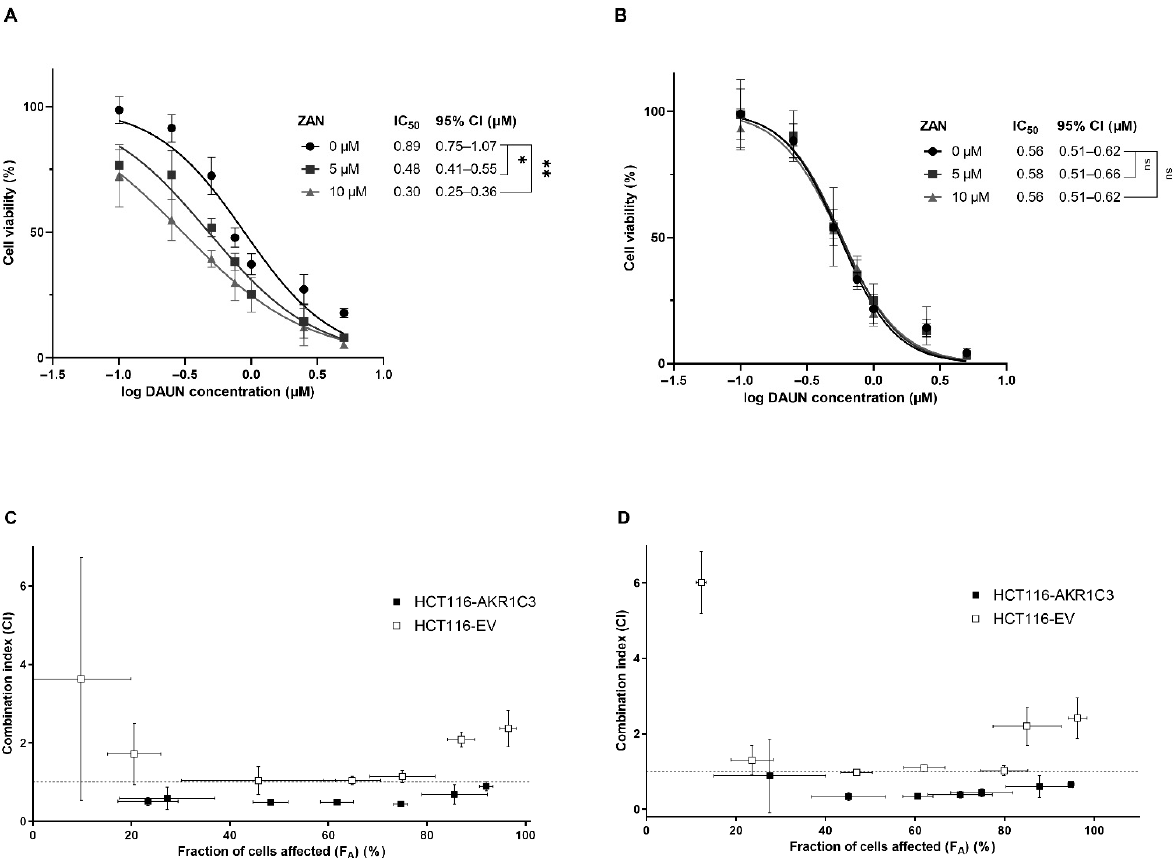
Figure 3. Zanubrutinib (ZAN) counteracts AKR1C3-mediated daunorubicin (DAUN) resistance in cancer cells. HCT116-AKR1C3 ( A ) and HCT116-EV ( B ) cells were treated with dimethyl sulfoxide